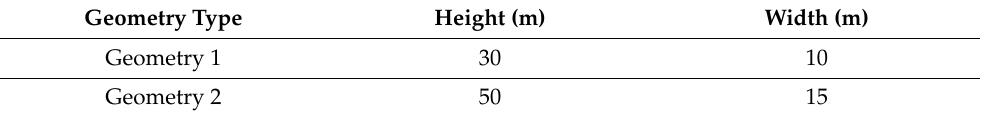
Table 3. The list of the examined sets of open stope’s geometrical